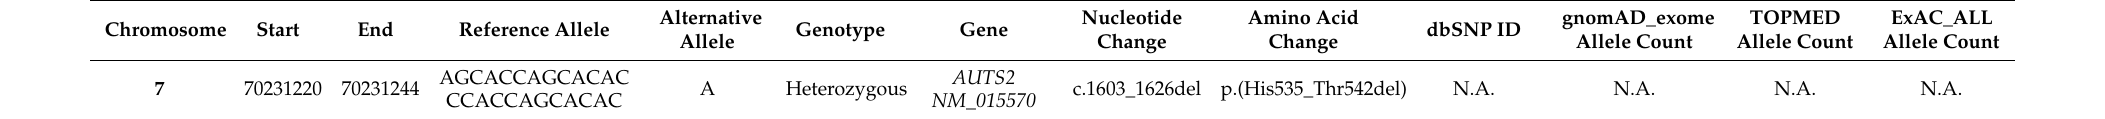
Table 1. Characteristics of the variant identified in the AUTS2